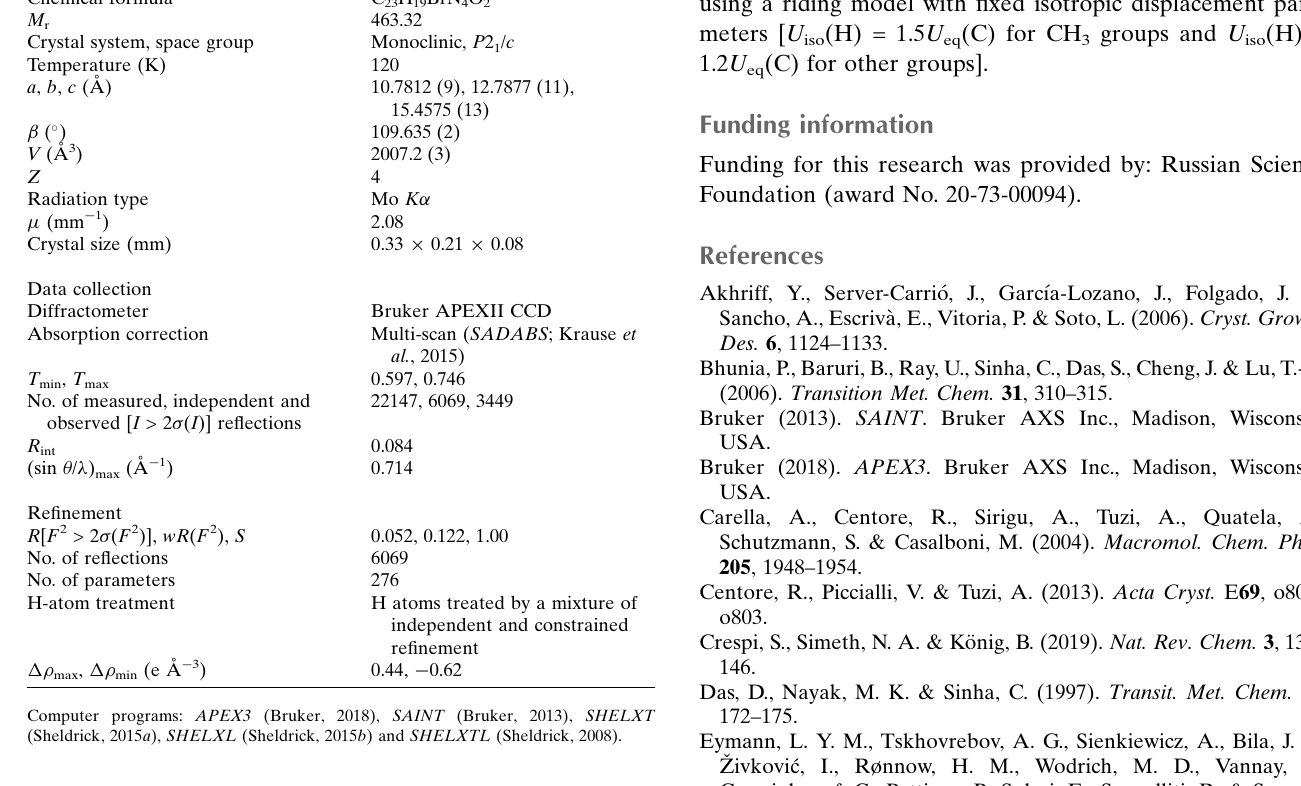
Table 2 Experimental details. Crystal data Chemical